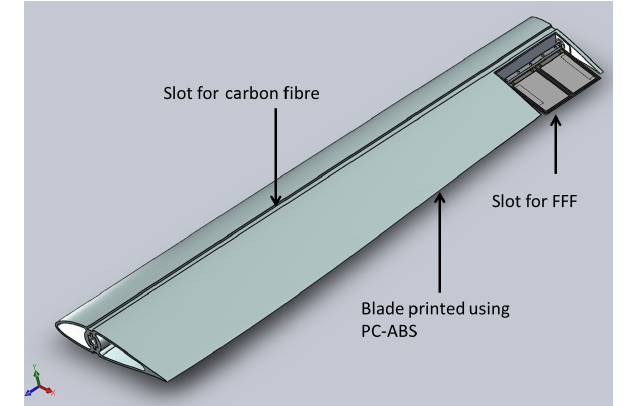
Figure 1. Blade CAD model.